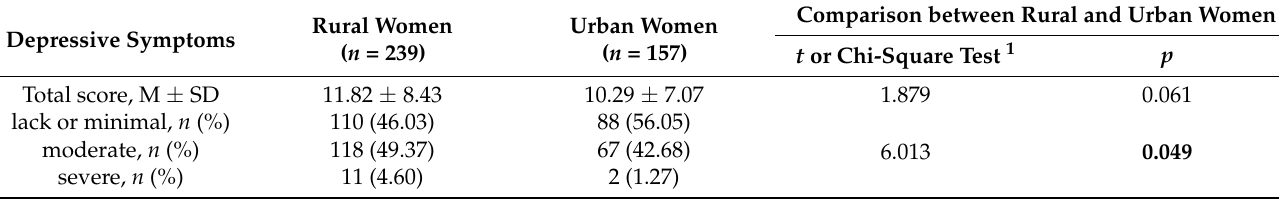
Table 2. Severity of depressive symptoms in study